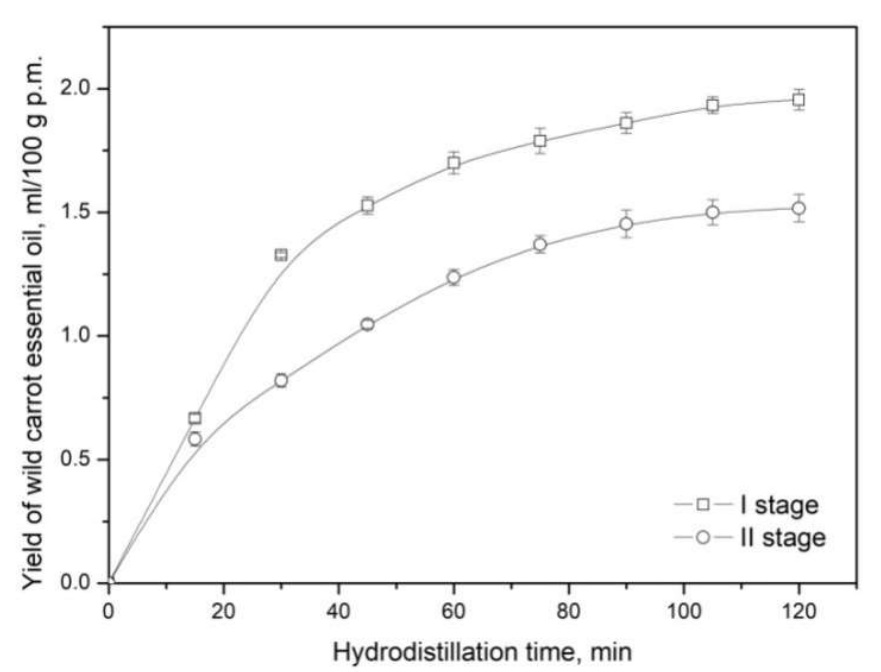
Figure 1. The EO yield (ml/100 g p.m) of wild carrot seeds in two maturity stages (I-II) obtained after 2 h of